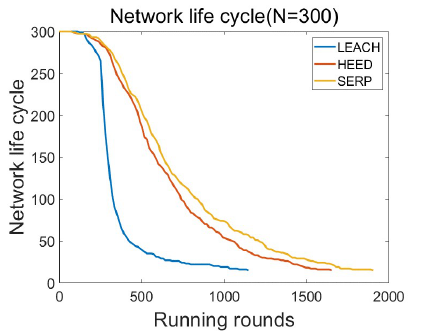
Figure 8. Network life cycle when the number of nodes N =